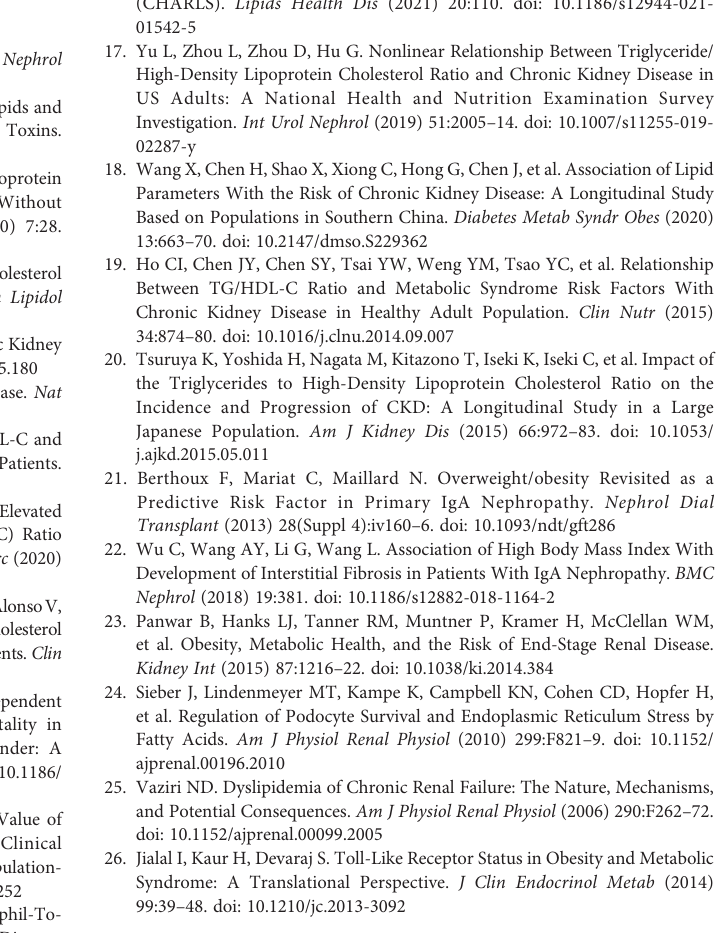
Supplementary Figure 1 | ROC curves (AUC) of TG/HDL-C for prediction of ESRD. Supplementary Figure 2 | Kaplan-Meier analysis for the endpoint of ESRD strati fi ed by quartile: Q1, fi rst quartile; Q2, median; Q3, third quartile, Q4, fourth